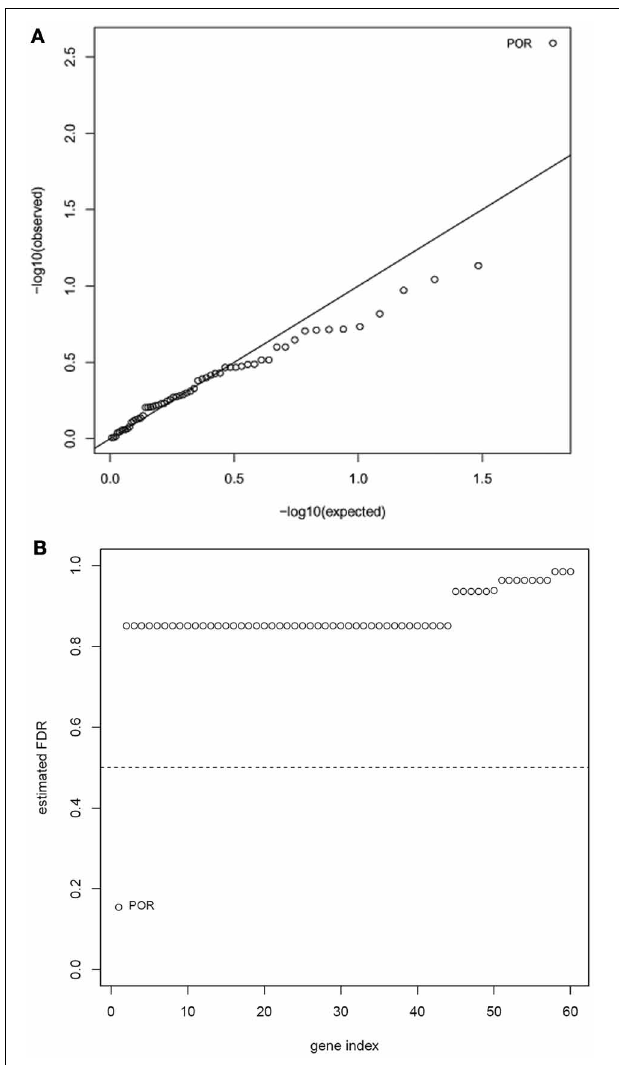
FIGURE 2 | Results of gene-based tests of association with drop in LVEF. (A) Quantile-quantile plot of nominal p -values for the 60 genes included in analysis—the observed p -values are plotted against p -values expected under the null hypothesis. (B) Benjamini-Hochberg false-discovery rates (FDRs) for the 60 analyzed genes. The strongest signal was detected for the POR gene (FDR adjusted p -value = 0 . 15).